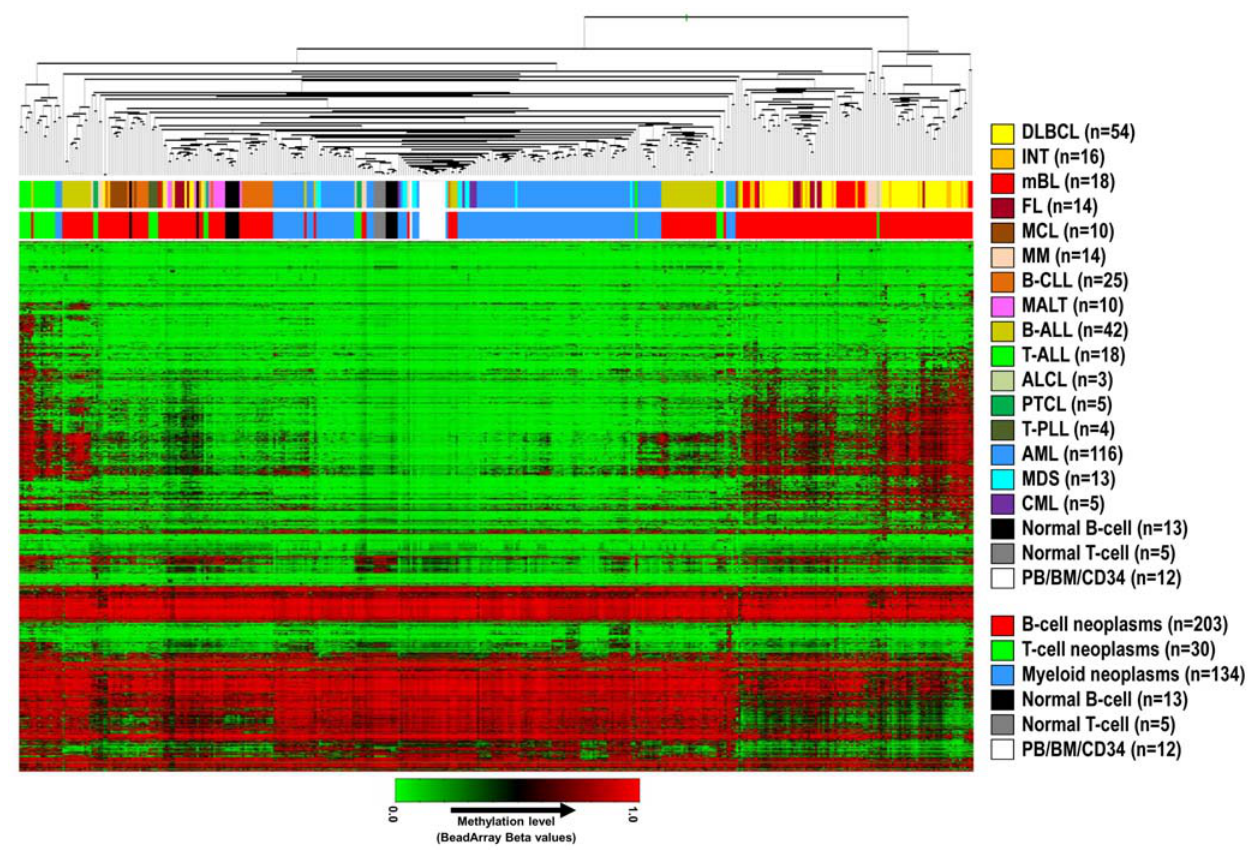
Figure 2. Hierarchical cluster analysis of DNA methylation data obtained from 367 HNs and 30 control samples. The upper bar below the dendrogram points to the specific HN subtype whereas the lower bar points to a classification of HNs according to the cell of origin (i.e. B-cell, T- cell, or myeloid cell). DLBCL: diffuse large B-cell lymphoma, INT: intermediate lymphoma, mBL: molecular Burkitt lymphoma, FL: follicular lymphoma, MCL: mantle cell lymphoma, MM: multiple myeloma, B-CLL: B-cell chronic lymphocytic leukemia, MALT: mucosa-associated lymphoid tissue lymphoma, B-ALL: precursor B-cell acute lymphoblastic leukemia, T-ALL: precursor T-cell acute lymphoblastic leukemia, ALCL: anaplastic large cell lymphoma, PTCL: peripheral T-cell lymphoma, T-PLL: T-cell prolymphocytic leukemia, AML: acute myeloid leukemia, MDS: myelodysplastic syndrome, CML: chronic myelogenous leukemia, PB: peripheral blood, BM: bone marrow, CD34: CD34-positive cells.